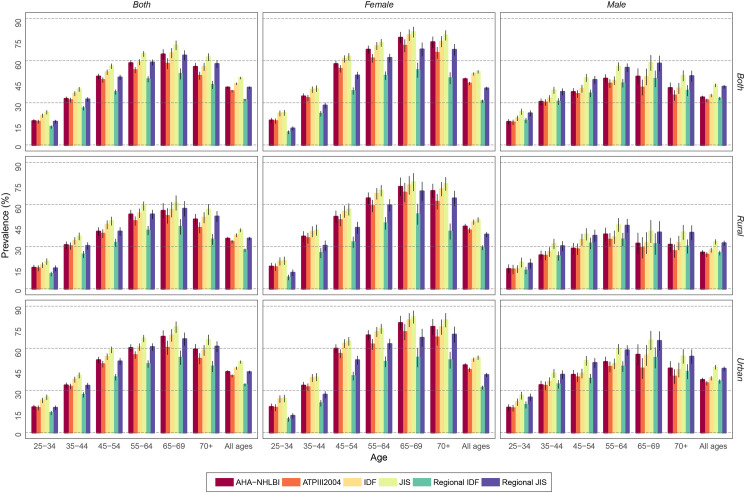
Age trends of MetS among the Iranian population based on sex and area of residence.